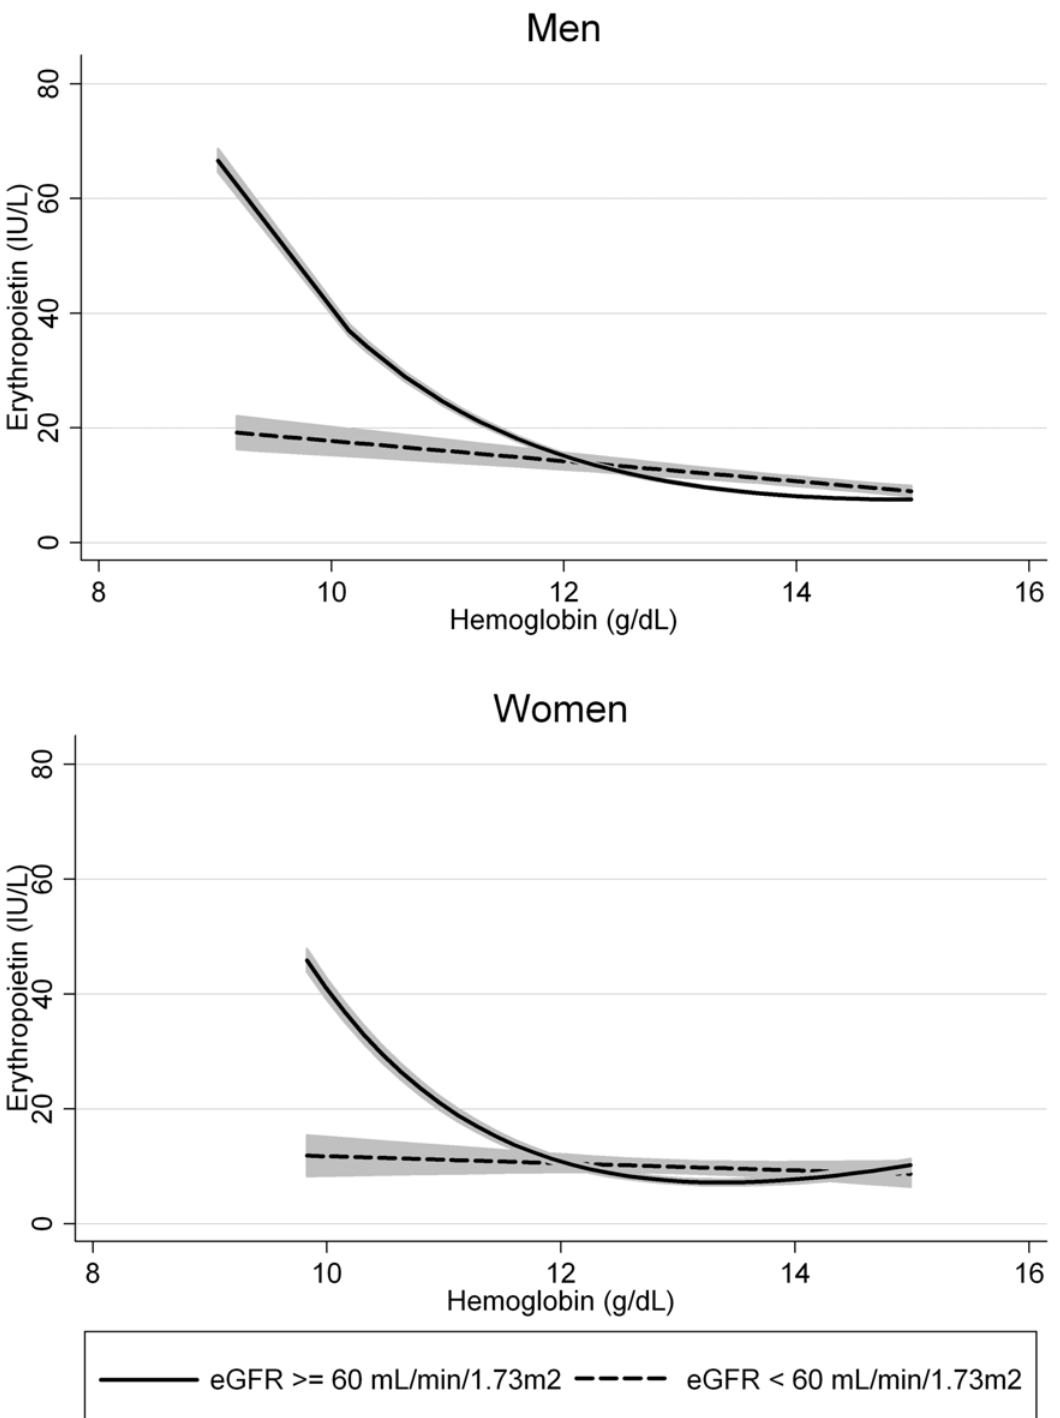
Fig 1. Relation between hemoglobin and erythropoietin in subjects with a normal or impaired renal function. Relation between hemoglobin and erythropoietin in men and women separated for normal (continuous line) and impaired renal function (dashed line) (eGFR (cid:1) or < 60 ml/min/1.73m 2 ), the 95% confidence interval is depicted in